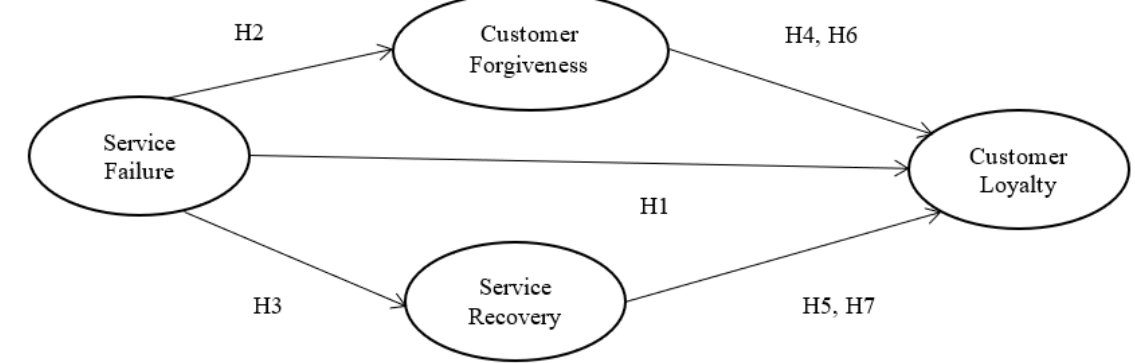
Figure 1: Research Framework and